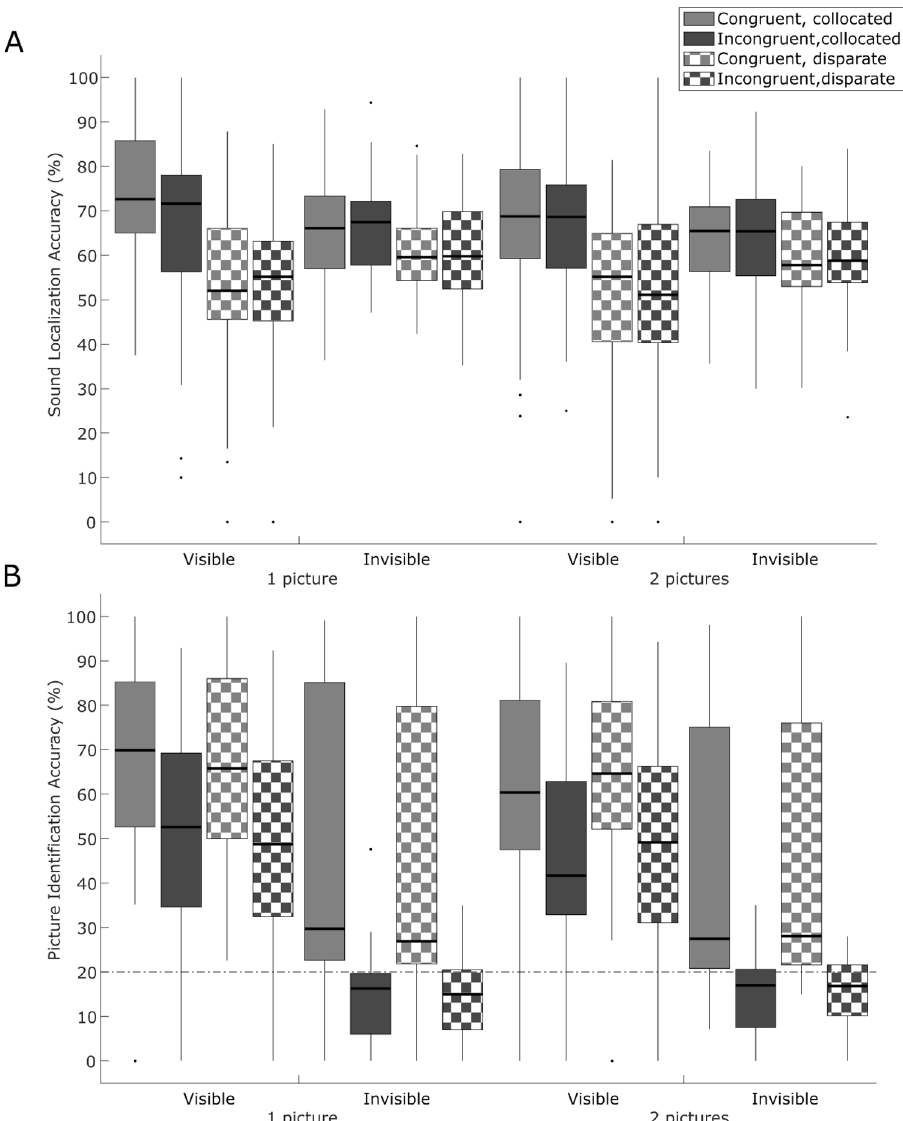
Figure 4. Sound localization and picture identification accuracies (Experiment 2). Box plots show interquartile range, with whiskers extending to most extreme data points excluding outliers, which are plotted individually. Thick lines in each plot indicate median values. ( A ) Sound localization accuracy (Left vs Right). ( B ) Picture identification accuracy (choice of 1 out of 5). Dashed line denotes chance level of